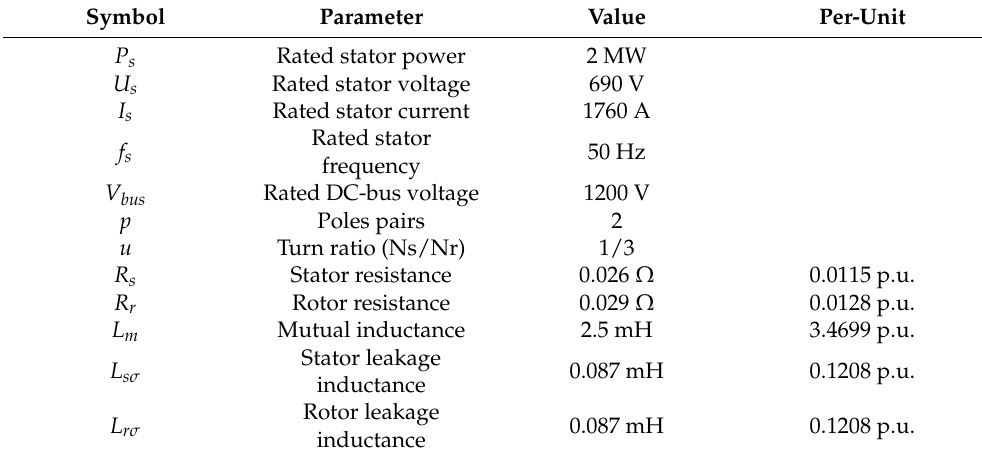
Table 1. Parameters of 2-MW